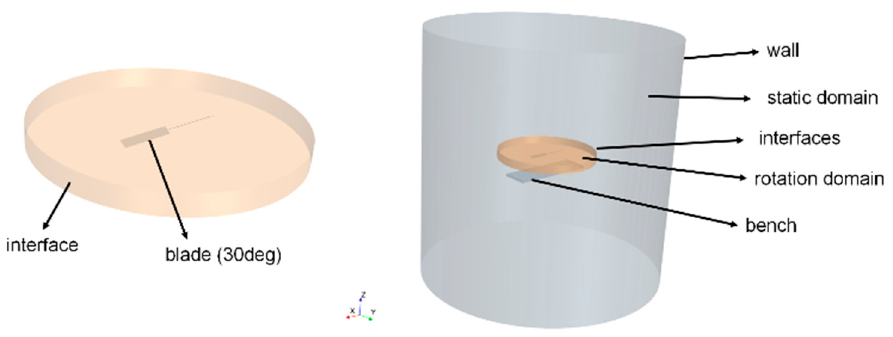
Figure 1. Mars Air Simulator and the experimental setup (( a ) is the MAS, ( b ) is the test set, ( c ) are the tested rotors, ( d ) is the schematic diagram of the test set).